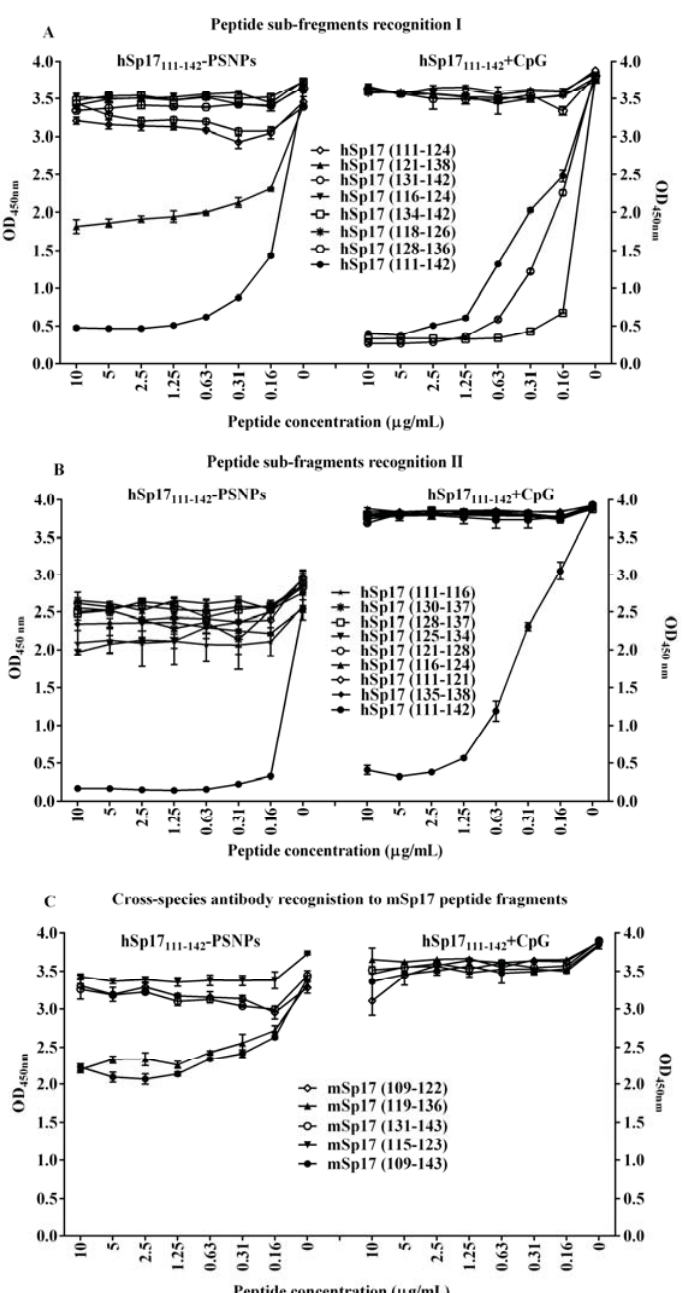
Figure 5. B cell epitope recognitions effected by the different adjuvant system. C57BL/6 mice ( n = 4 mice/group) were immunised 4 times (weekly apart) with hSp17 111–142 -PSNPs vaccine formulation (containing 36 (cid:3)g /ml of hSp17 111–142 peptide and 1% PSNPs, 100 (cid:3)L/mouse/injection) or with CpG adjuvated hSp17 111–142 vaccine formulation (at equivalent peptide dose, i.e. , (36 (cid:3)g peptide + 20 (cid:3)g CpG)/mouse/injection). 13 days after the last immunisation, sera were collected, and pooled for each group. A&B: hSp17 111–142 epitope recognitions. Seven ( A ) and nine ( B ) peptide fragments within the hSp17 111–142 region as well as hSp17 111–142 itself were used to compete for the antibody reactivities in sera produced by both vaccine formulations. ( C ): Antibody cross-species reactivity to mSp17 fragments. Five mSp17 peptides were used to compete for antibody reactivity in sera produced by both vaccine formulations. Data presented as Average OD 450 nm ± SD (triplicated in